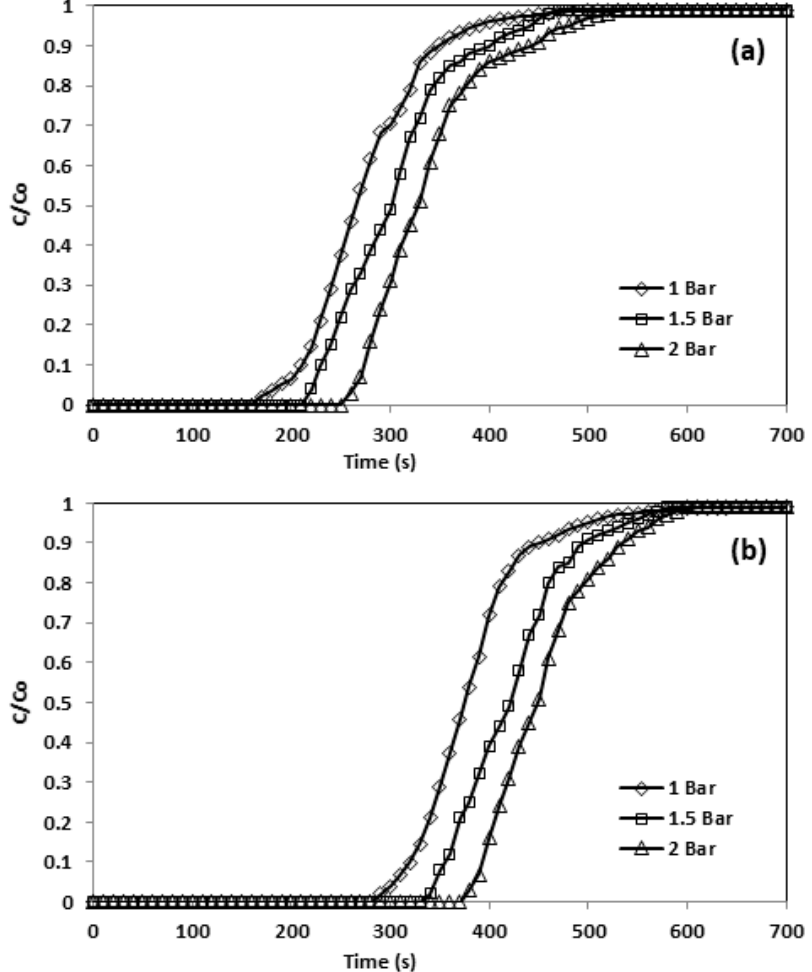
Figure 14. Breakthrough curve and e ff ect of pressure ( a ) CNFCM and ( b ) modified CNFCM in constant T = 30 ◦ C, Flow = 50 mL / min, and 10% CO